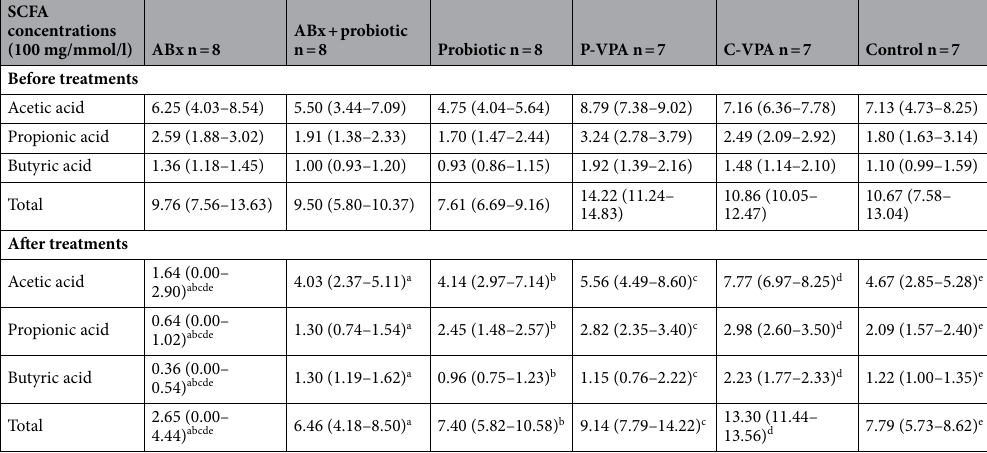
Table 2. Analysis of the short chain fatty acids (acetic acid, propionic acid and butyric acid) concentrations (100 mg/mmol/l) in the faecal samples before and after the treatments. ABx: broad-spectrum antibiotics treated group, ABx + probiotic: broad-spectrum antibiotics- and probiotic treated group, Probiotic: probiotic treated group, P-VPA: valproic acid and probiotic treated group, C-VPA: valproic acid treated group,